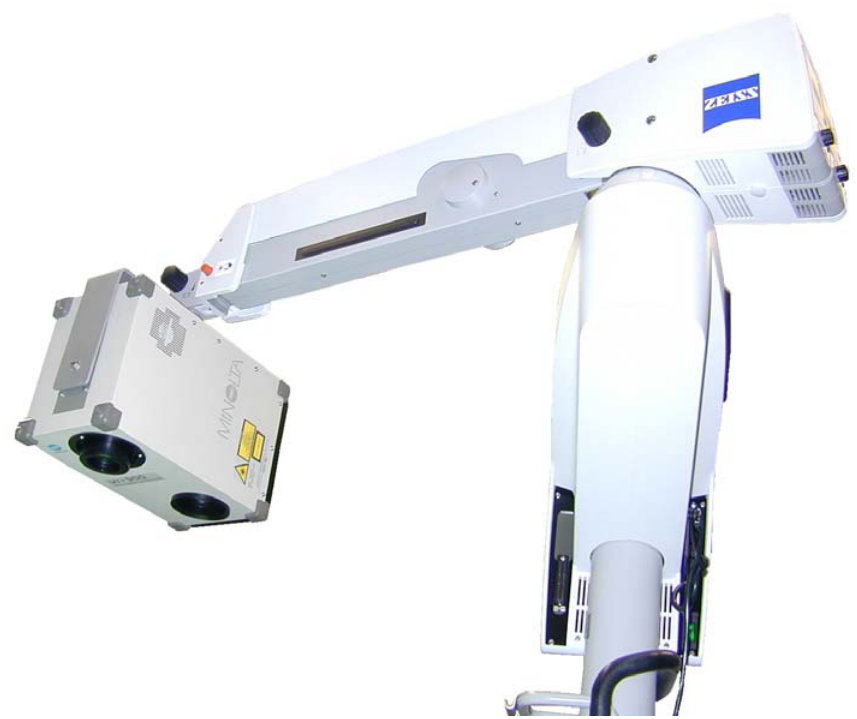
Fig. 1 Laser surface scanner mounted on an adjustable stand.